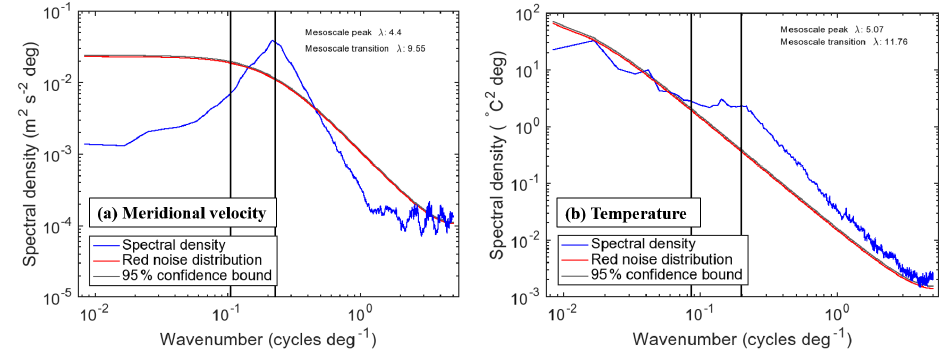
Figure 2. Zonal wavenumber spectral density estimate of (a) meridional velocity and (b) temperature in the Atlantic at 40 ◦ N from POP. The vertical lines and text indicate the wavelength (in degrees) of the mesoscale transition and peak as calculated from each spectral estimate, based on the logarithmically smoothed spectral profile. The red and gray curves indicate the red noise distribution expected from lag-1 (model grid-scale) autocorrelation and the corresponding 95% upper confidence